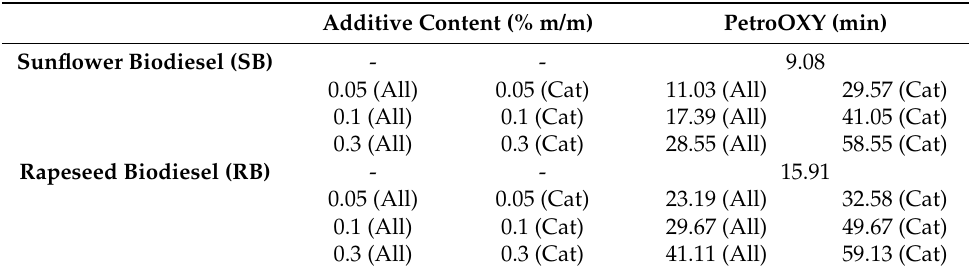
Table 3. Oxidation stability of the biodiesel and its blends with additives: results for 4-allyl-2,6- dimethoxyphenol (All) and catechol (Cat), blended with sunflower and rapeseed biodiesel. SB and RB were both obtained using methanol at the appropriate molar